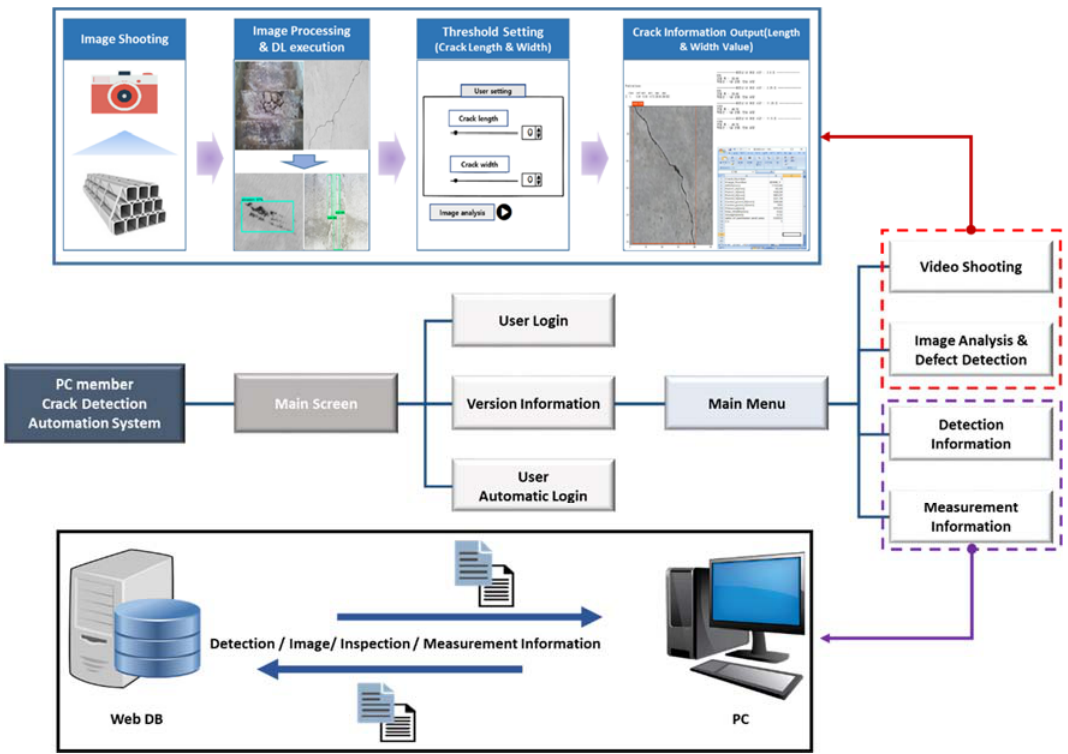
Figure 13. Functional block diagram of the automated PC member crack detection system.